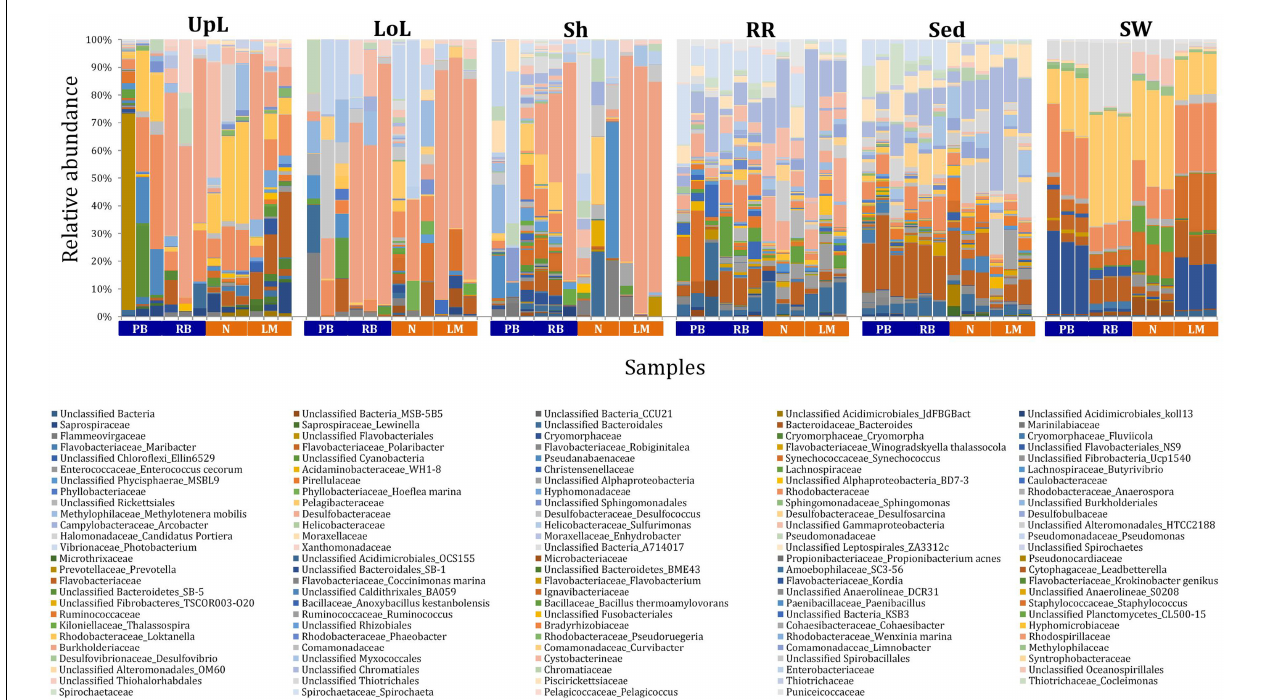
FIGURE 3 | Bacterial community composition across seagrass microenvironments. Beta diversity of bacterial microbiomes across the six microenvironments within the plant and its surroundings. Triplicate samples per microenvironment within each of the four sampling sites ( n = 72) are colored by the highest assigned taxonomic level. Unique OTUs were summarized at the species level, and the representation of taxonomic groups within each sample are plotted. Only representative species with a relative abundance > 1% in all samples are shown to help remove visual clutter. UpL, upper leaf; LoL, lower leaf; Sh, sheath; RR, roots and rhizomes; Sed, sediment; SW, seawater; PB, Palm Beach; RB, Rose Bay; N, Narrabeen Lagoon; LM, Lake Macquarie.